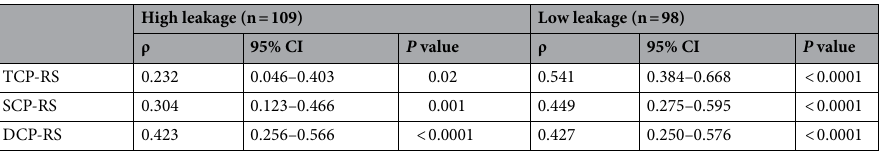
Table 2. Comparison of 95% confidence interval for Spearman’s rank correlation coefficient (ρ). TCP, SCP, DCP-RS: the relationship of TCP, SCP, and DCP and RS with FD. CI confidence interval, DCP deep capillary plexus layer, SCP superficial capillary plexus layer, TCP total capillary plexus layer. R: A language and environment for statistical computing. R Foundation for Statistical Computing, Vienna, Austria. URL https:// www.R- proje ct. org/.